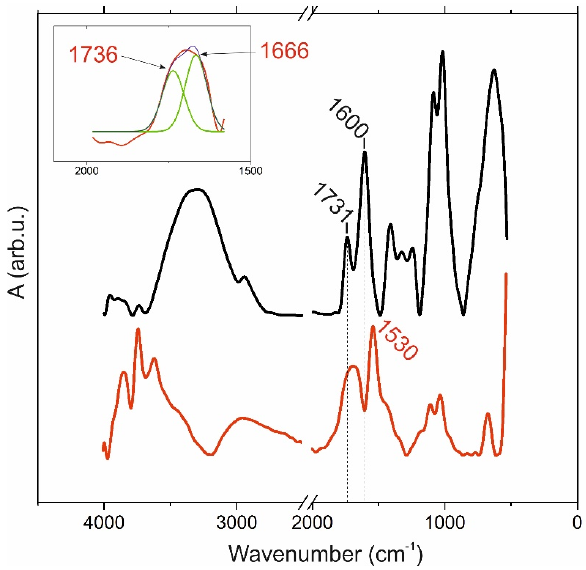
Figure 2. FTIR absorption spectra: black spectrum, powder of pectin with DE 50%; red spectrum, gel obtained from pectin 50 solution with a concentration of 3%. The selected area is the range of vibrations of carboxyl groups from the spectrum of the